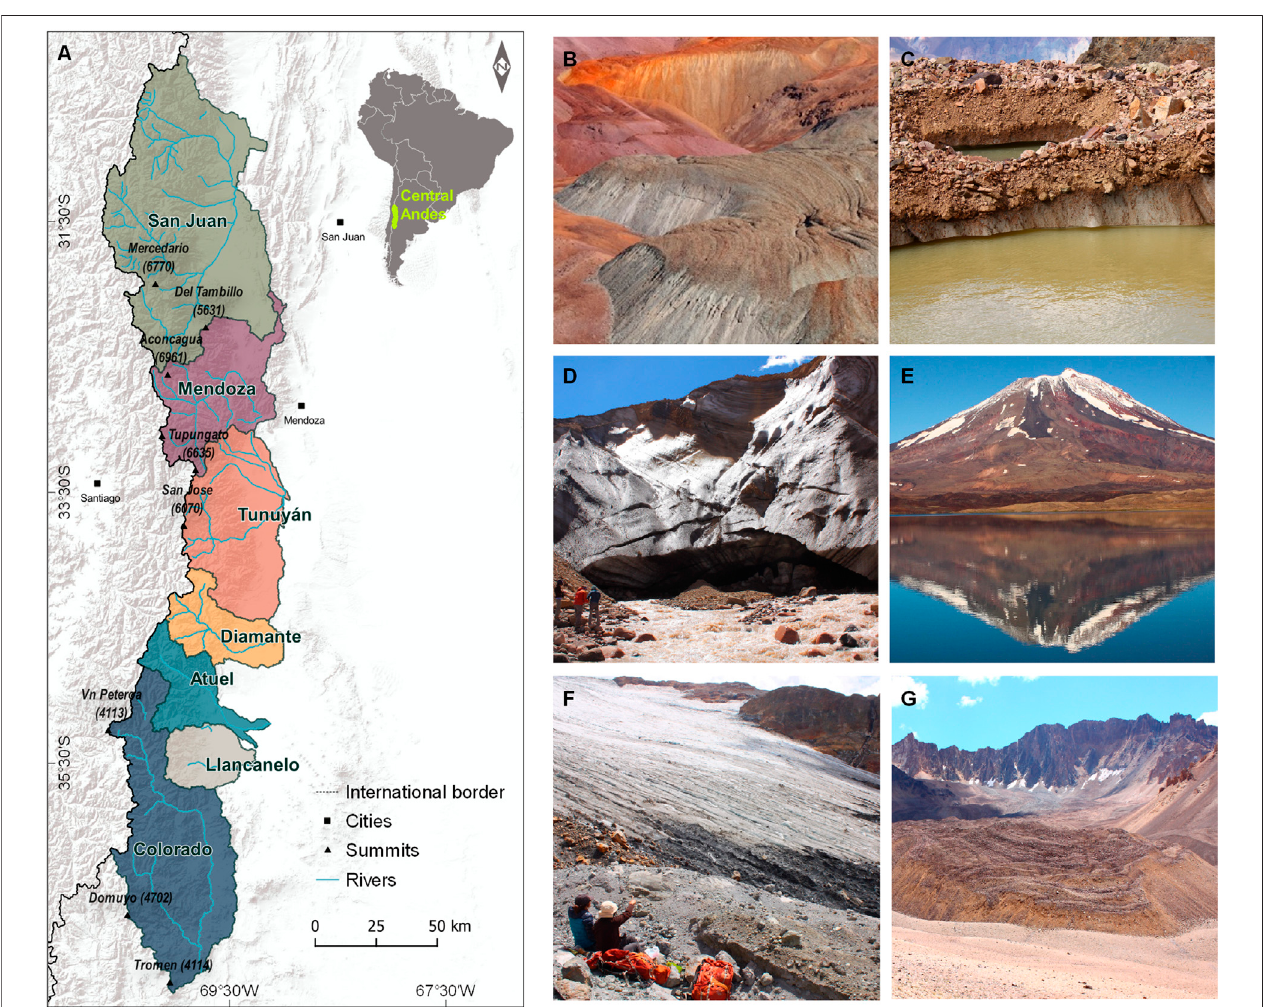
FIGURE 1 | (A) Map of the main river basins in the Central Andes of Argentina. (B – G) Some examples of the ice masses that can be found in this region (B) The Calingasta rock glacier, San Juan basin. (C) Thermokarst in a debris-covered glacier, Mendoza basin. (D) Proglacial stream and ice front of the Tunuyán glacier, the largestglacierin theCentral Andes ofArgentina. Note thedebriscoverat theglaciersurface,Tunuyán basin. (E) Clean iceglaciersand perennialsnow fi eldsinthe Maipo volcano area, Diamante basin. (F) The Azufre glacier, Colorado basin. Since 2010 the glacier is partially covered by a thin layer of ash due to the eruption of the neighboring Peteroa volcano. (G) Debris-covered ice with rock glacier, Llancanelo basin. (Photos: M. Castro, IANIGLA).